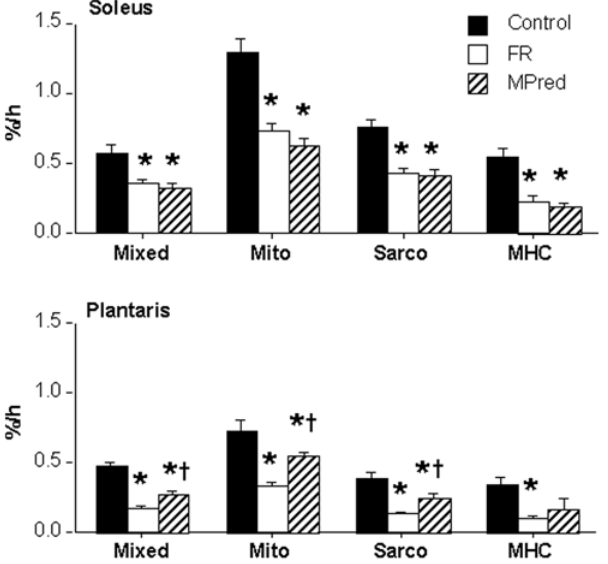
Figure 2. Fractional synthesis rates (FSR) of muscle proteins in soleus and plantaris. Data shown as mean 6 SEM for total (mixed) proteins, the mitochondrial (mito) and sarcoplasmic (sarco) subfrac- tions, and the contractile protein myosin heavy chain (MHC). FR, food restricted; MPred, methylprednisolone. * Less than Control, P , 0.05 , { Higher than FR, P , 0.05 . There was a trend for lower FSR of MHC in plantaris of MPred versus Control, P = 0.069 .